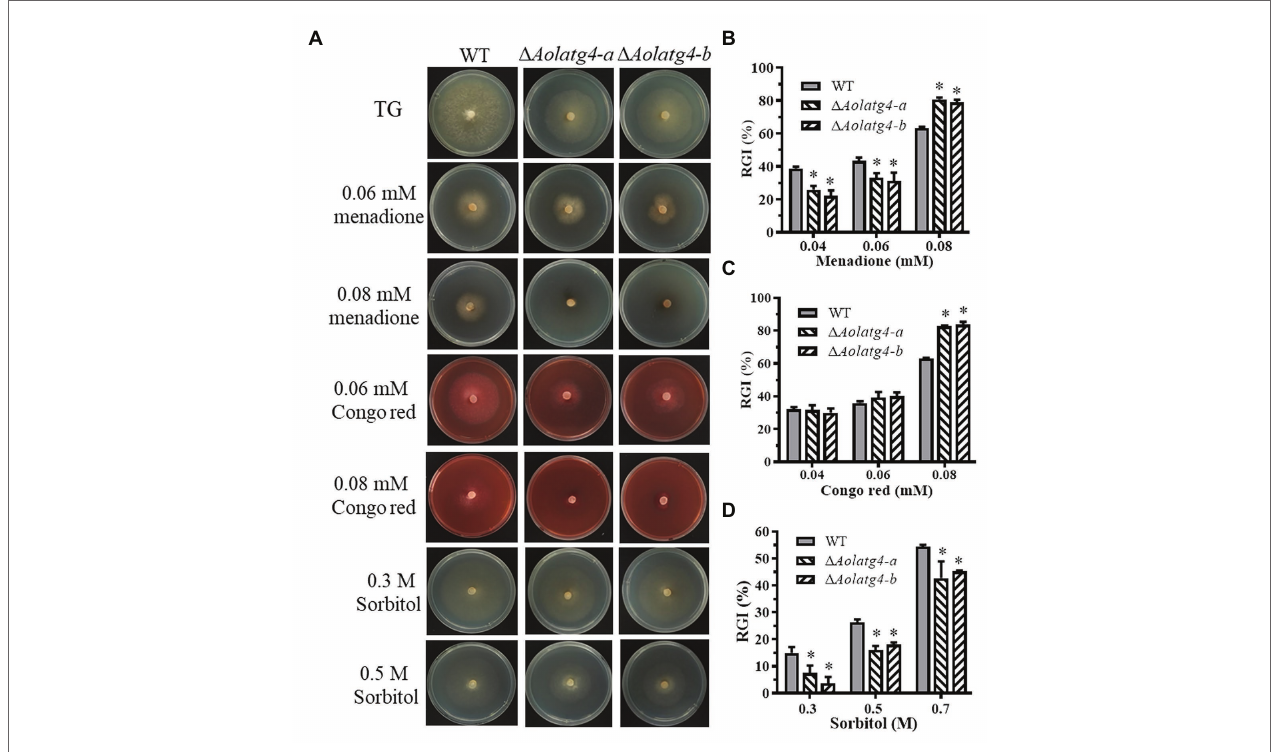
FIGURE 3 | Comparison of stress resistance between WT and Δ Aolatg4 mutants. (A) The WT strain and Δ Aolatg4 mutant were incubated on TG medium containing menadione, sorbitol, and Congo red. (B) Relative growth inhibition (RGI) values of the fungal strains incubated on TG medium containing 0.04–0.08 mM menadione for 7 days. (C) RGI values of the fungal strains incubated on TG medium containing 0.04–0.08 mM Congo red for 7 days. (D) RGI values of the fungal strains incubated on TG medium containing 0.3–0.7 M sorbitol for 7 days. Each experiment was performed three times. Error bars: standard deviation, asterisk: significant difference between mutant and WT (Tukey’s HSD, p <